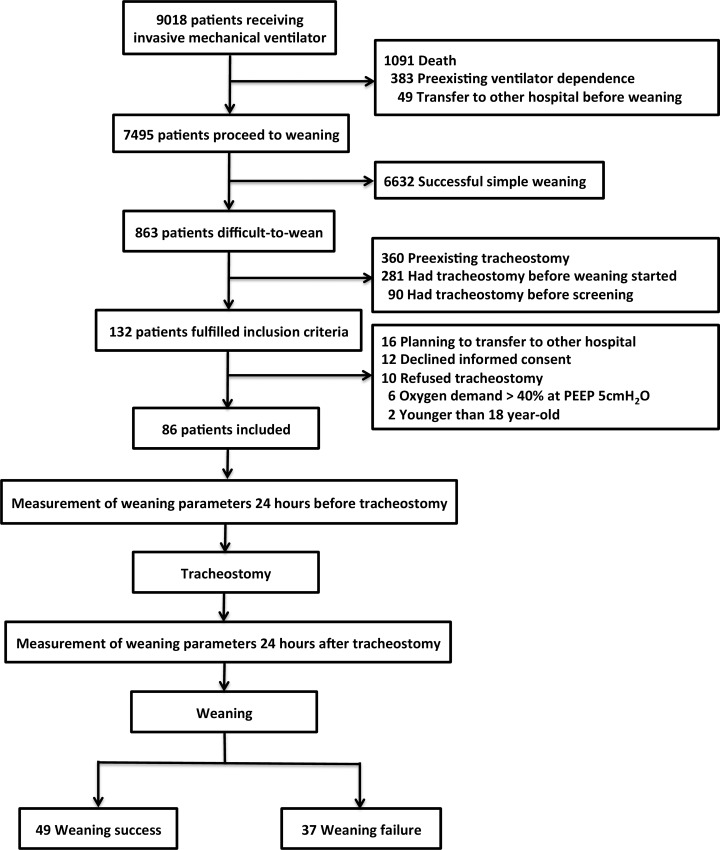
The flow chart of this study.